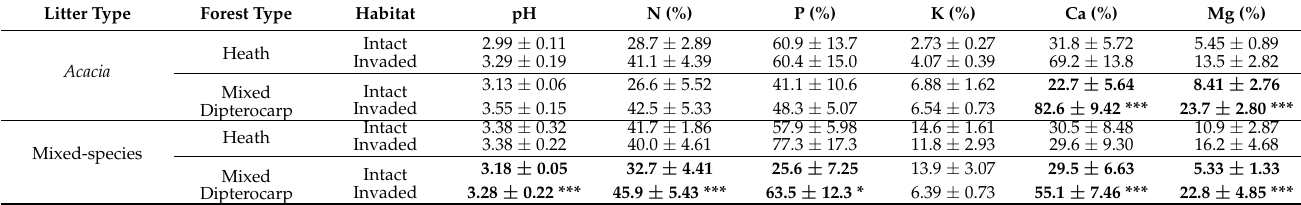
Table 5. Mean pH values and mean percentage of nutrients (N, P, K, Ca, and Mg) remaining in litter at day 336 for the litter decomposition experiment. Litter bags containing Acacia mangium litter and mixed-species litter were deployed in heath forest (intact and Acacia -invaded) and mixed dipterocarp forest (intact and Acacia